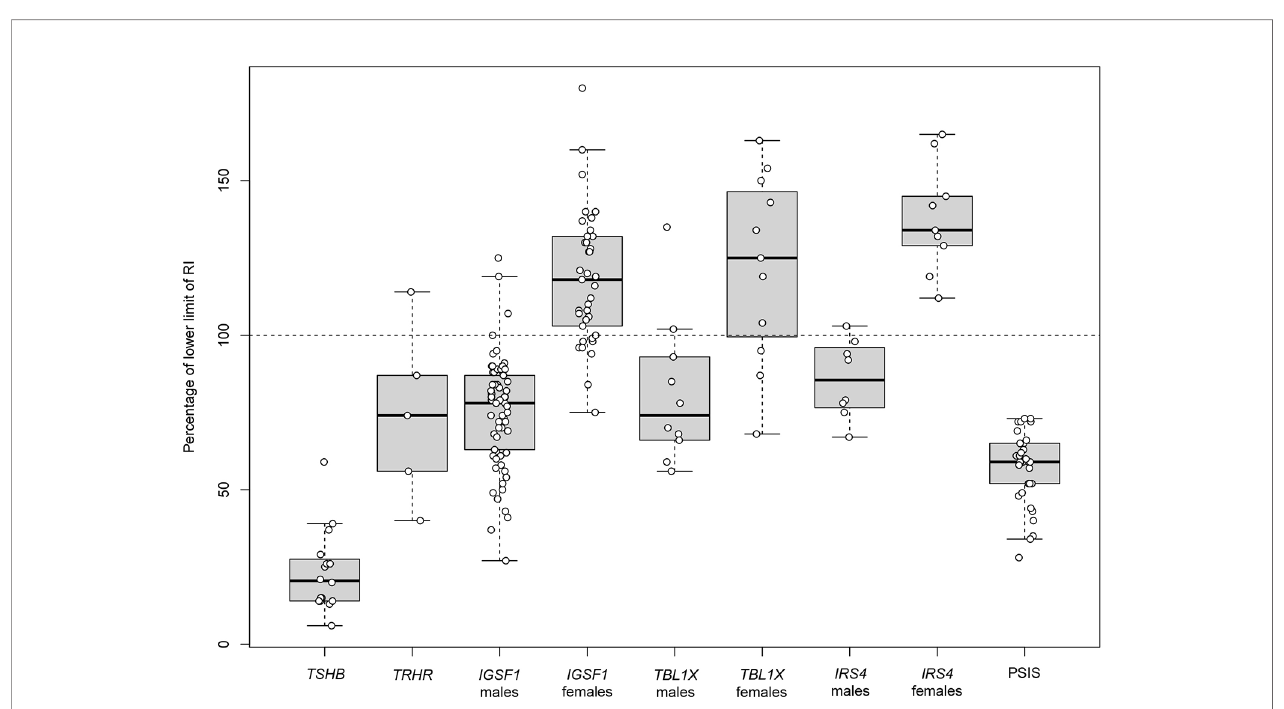
FIGURE 1 | Pre-treatment serum FT4 concentrations in patients with central congenital hypothyroidism. First pre-treatment serum FT4 concentrations in patients with isolated central CH and in patients with central CH as part of CPHD caused by PSIS. Data of isolated central CH were extracted from published studies/case reports ( Supplementary Table 1 ), and expressed as percentage of the lower limit of given FT4 reference intervals. Data about central CH as part of PSIS were extracted from the study by Naafs et al. (19). FT4 values of PSIS patients measured at day 3-7 and day 12-16 after birth were compared to the lower limit of the plasma FT4 reference interval at these ages (20.5 pmol/L and 15.3 pmol/L, respectively) (31). Boxes represent median, 1st and 3rd quartile, and whiskers represent minimum and maximum. Individual data points are given as circles. CH, congenital hypothyroidism; CPHD, combined pituitary hormone de fi ciencies; FT4, free thyroxine; PSIS, pituitary stalk interruption syndrome; RI, reference